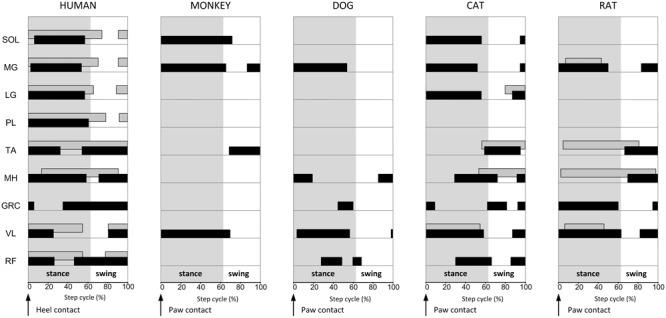
Locomotor electromyographic activity in the intact human, monkey, dog, cat, and rat. Duration of leg/hindlimb muscle activity is shown against normalized step cycle that starts at heel or paw contact; shaded areas mark the stance phase duration. Forward walking is shown as a solid black box whilst backward walking is a patterned box. Absent boxes among muscles is due to the lack of available data. Walking muscle activation patterns adopted and modified from Knikou et al. (2009) and La Scaleia et al. (2014) (human EMG); Courtine et al. (2005) (monkey EMG); Deban et al. (2012) and Goslow et al. (1981) (dog EMG); Buford and Smith (1990) and Yakovenko et al. (2002) (cat EMG); Thota et al. (2005) and Courtine et al. (2009) (rat EMG). SOL, soleus; MG, medialis gastrocnemius; LG, lateral gastrocnemius; PL, peroneus longus; TA, tibialis anterior; MH, medial hamstrings; LH, lateral hamstrings; GRC, gracilis; VL, vastus lateral; RF, rectus femoris.